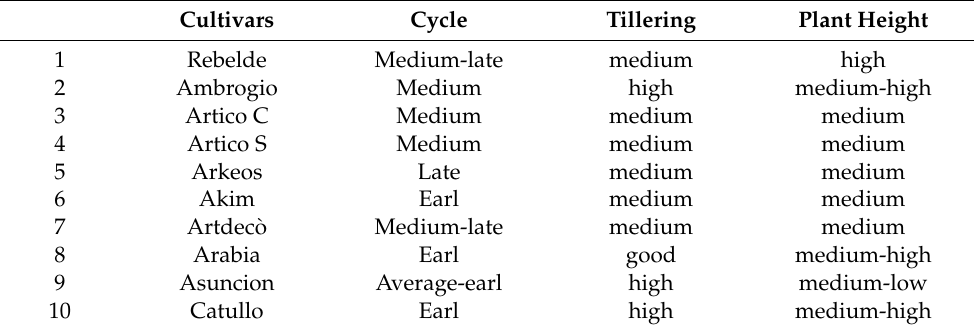
Table 1. Winter wheat characteristics: Cultivars name, Cycle, Tillering, Plant Height. Cultivars Cycle